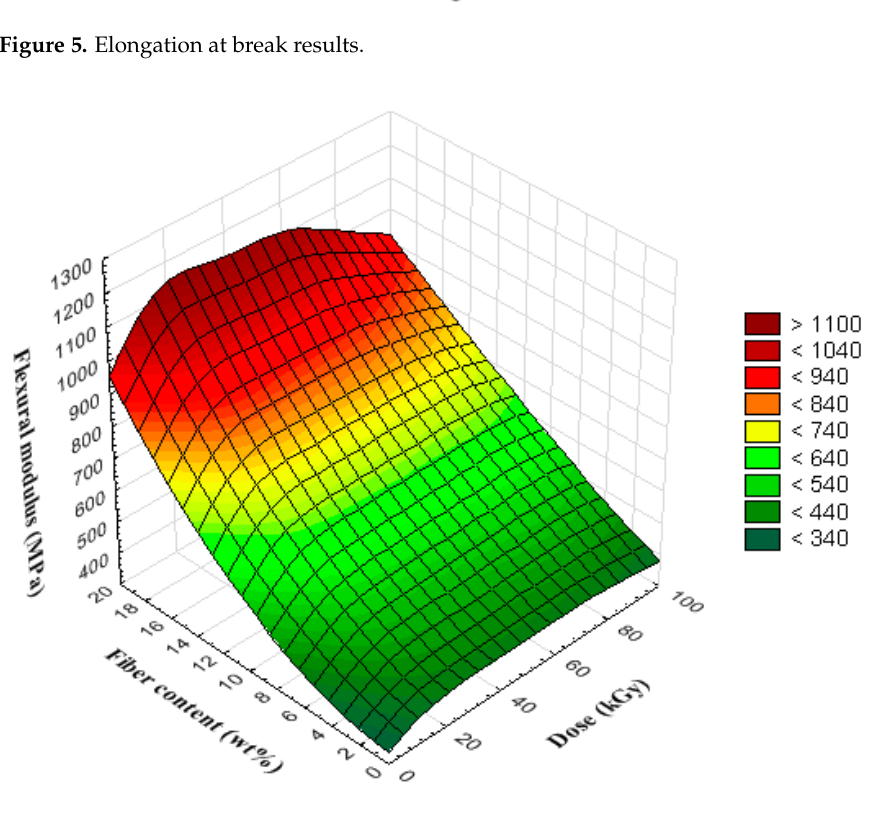
Figure 6. Flexural modulus results.